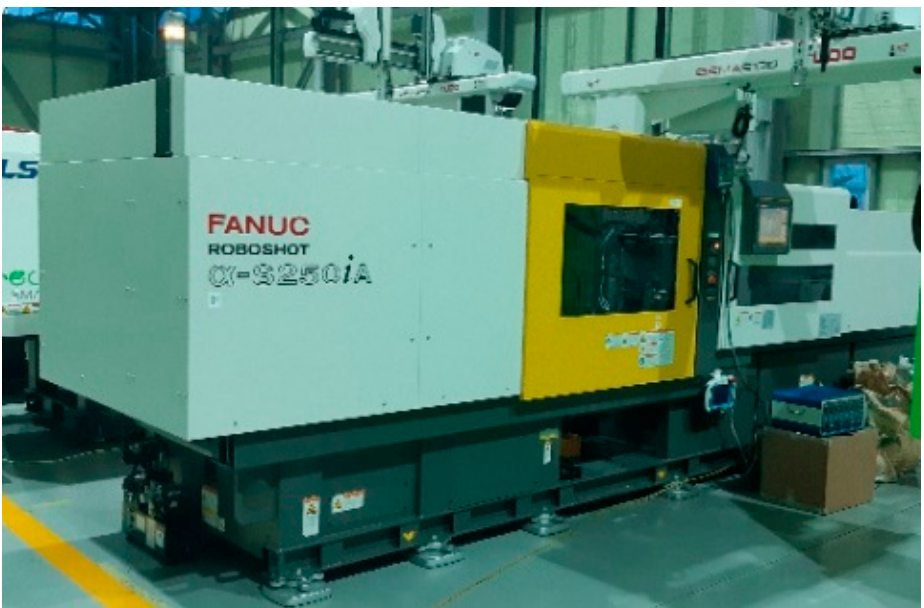
Table 2. General specifications of injection molding machine (ROBOSHOT α -S250iA, FANUC). Item